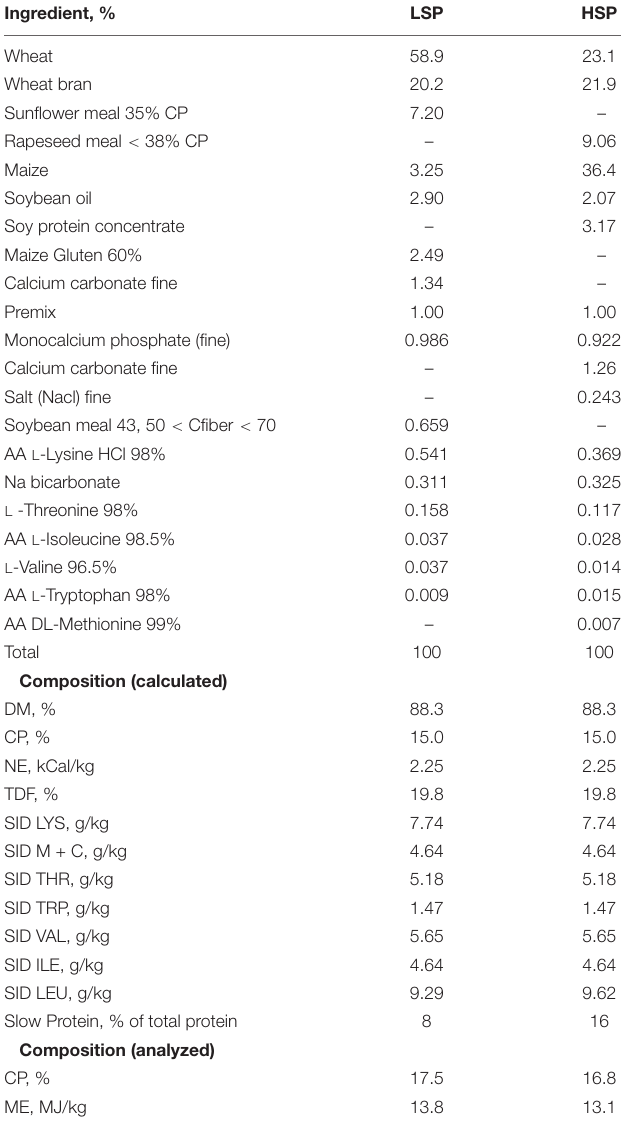
TABLE 1 | Ingredients and nutrient composition of experimental diets with 8% slow protein (LSP) and 16% slow protein (HSP) of total protein. Ingredient,